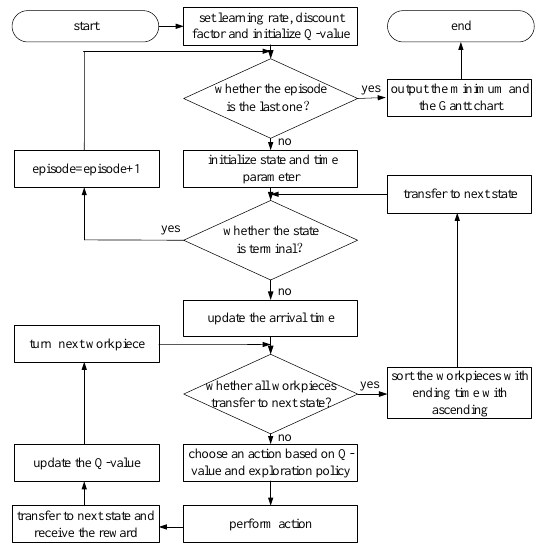
Figure 2. The flow chart of the reinforcement learning for HFSP.